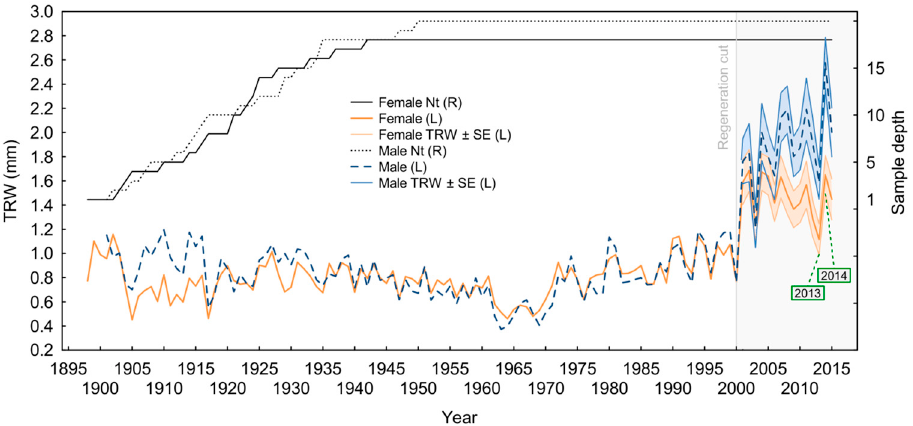
Figure 5. Differences in radial growth between male and female yew individuals. For the period of 2000 to 2015, values of TRW ± SE (standard error of raw mean chronology) are shown. TRW: tree-ring width, Nt: number of trees, R: right y-axis, L: left y-axis. Forests 2017 , 8 , 289